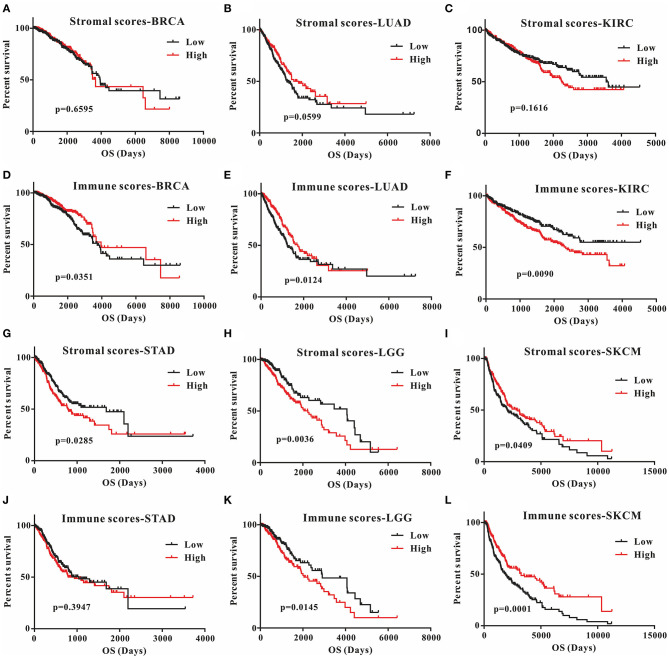
Correlation of stromal scores and immune scores with prognosis in six different tumor types by Kaplan-Meier survival curves. (A–C,G–I) Kaplan-Meier survival curves for BRCA, LUAD, KIRC, STAD, LGG, and SKCM grouped by stromal scores. (D–F, J–L) Kaplan-Meier survival curves for BRCA, LUAD, KIRC, STAD, LGG, and SKCM grouped by immune scores. Low, low score group (black line); high, high score group (red line).